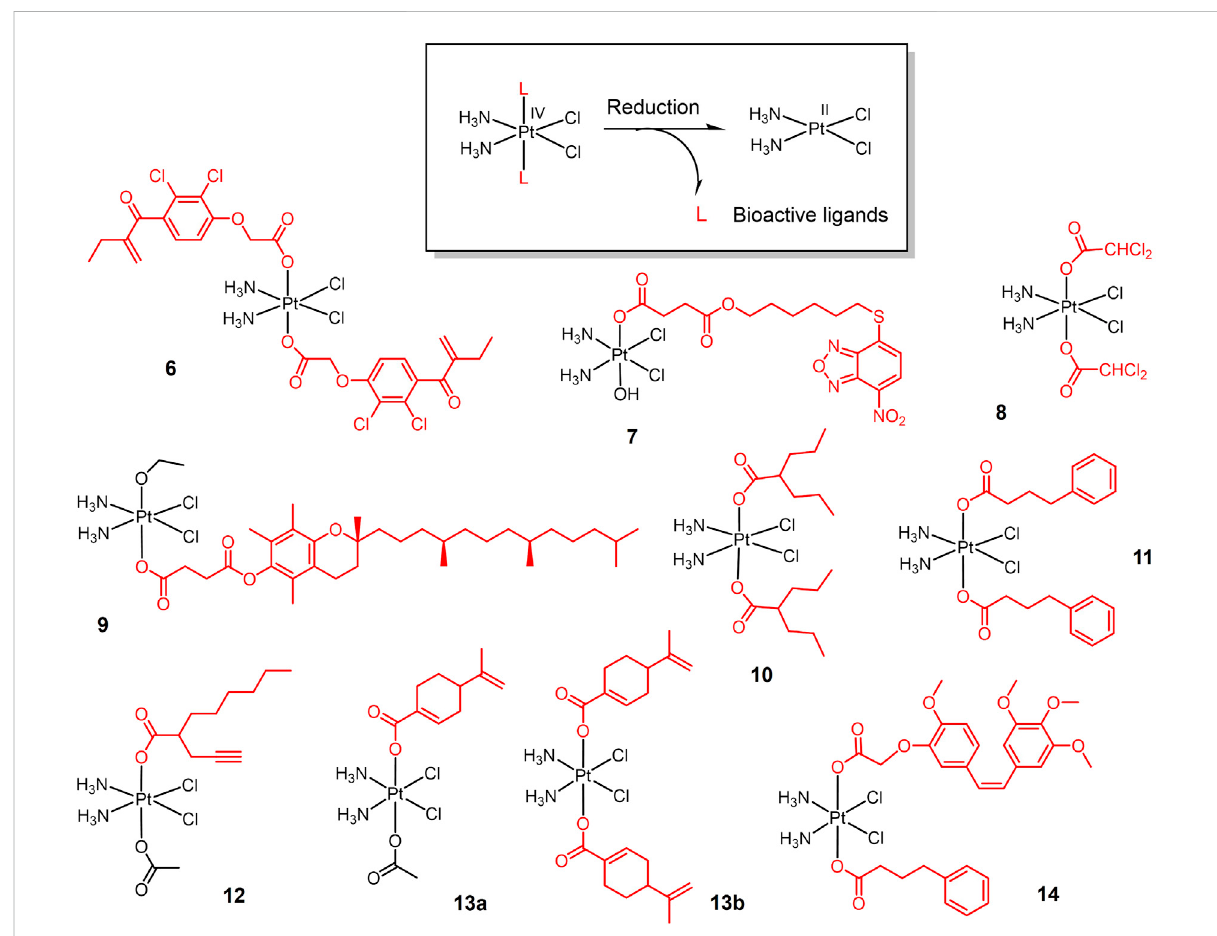
FIGURE 2 Redox-responsivePt(IV)prodrugsundergo reductionto formactivePt(II)drugs accompanied bythereleasebioactivemolecules. Complexes 6 and 7 bear glutathione-S-transferase inhibitors; Complex 8 bears dichloroacetate as pyruvate dehydrogenase kinase inhibitor; complex 9 bears α - TOS as inhibitor for Bcl-xL-Bax protein-protein interaction; complexes 10-12 bear histone deacetylase inhibitors (HDACi); Complexes 13a,b bear perillic acid as anti-metastatic molecule; and complex 14 bears dual bioactive ligands: phenylbutyrate as HDACi and CA4 as tubulin polymerization inhibitor,